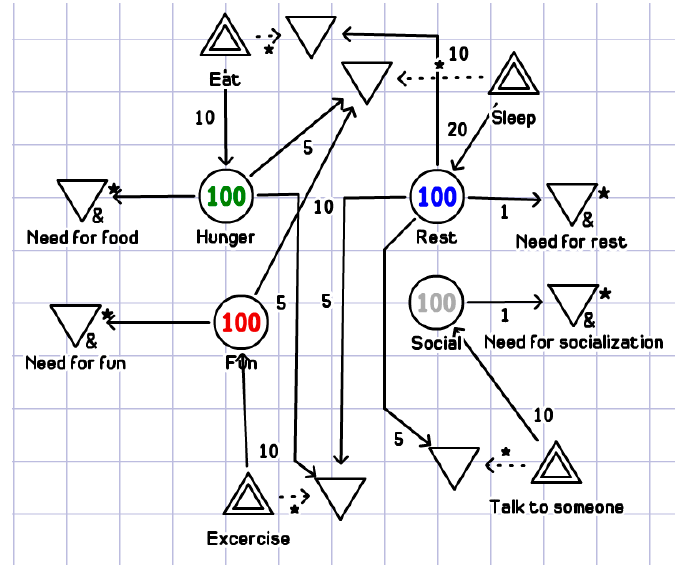
Figure 3. Model of the person with dementia’s needs and actions.